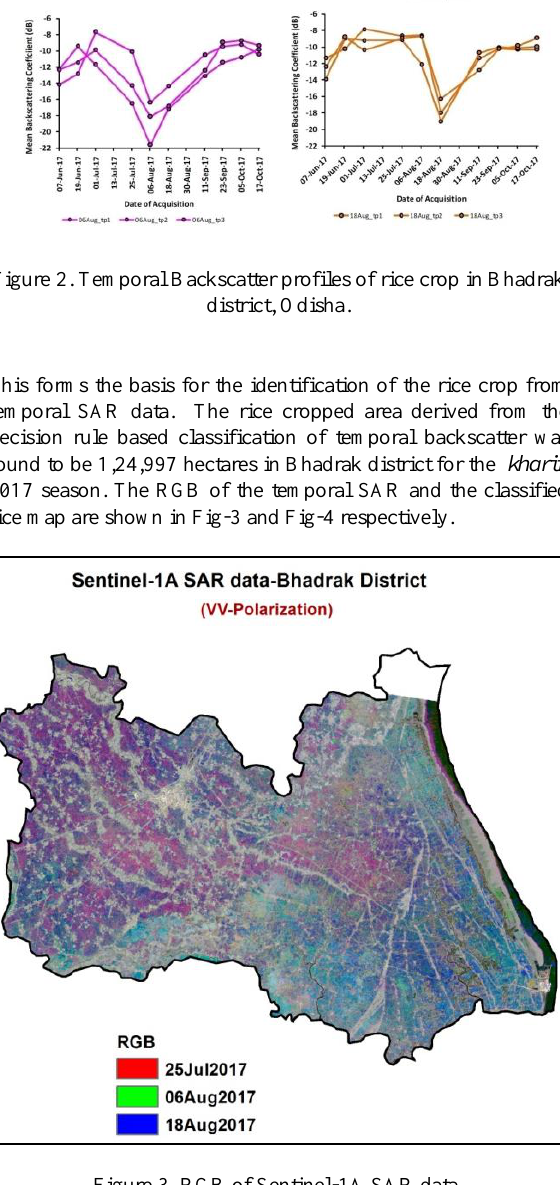
Figure.3. RGB of Sentinel-1A SAR